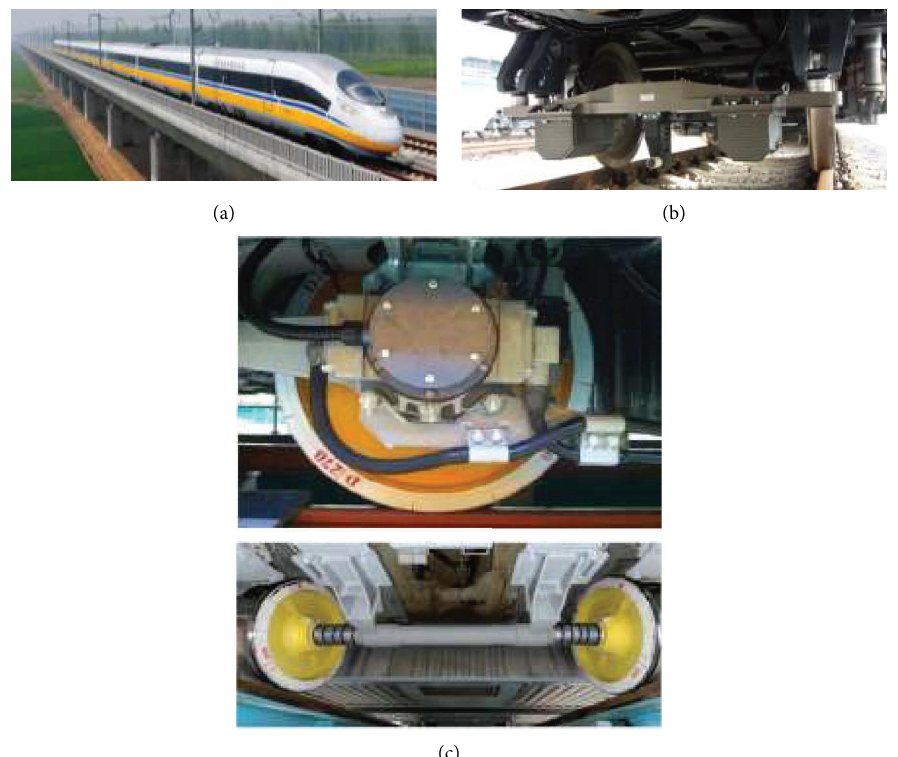
Figure 1: High-speed comprehensive inspection train. (a) CRH380BJ EMU, (b) track geometry inspection system, and (c) wheel-rail force inspection system.